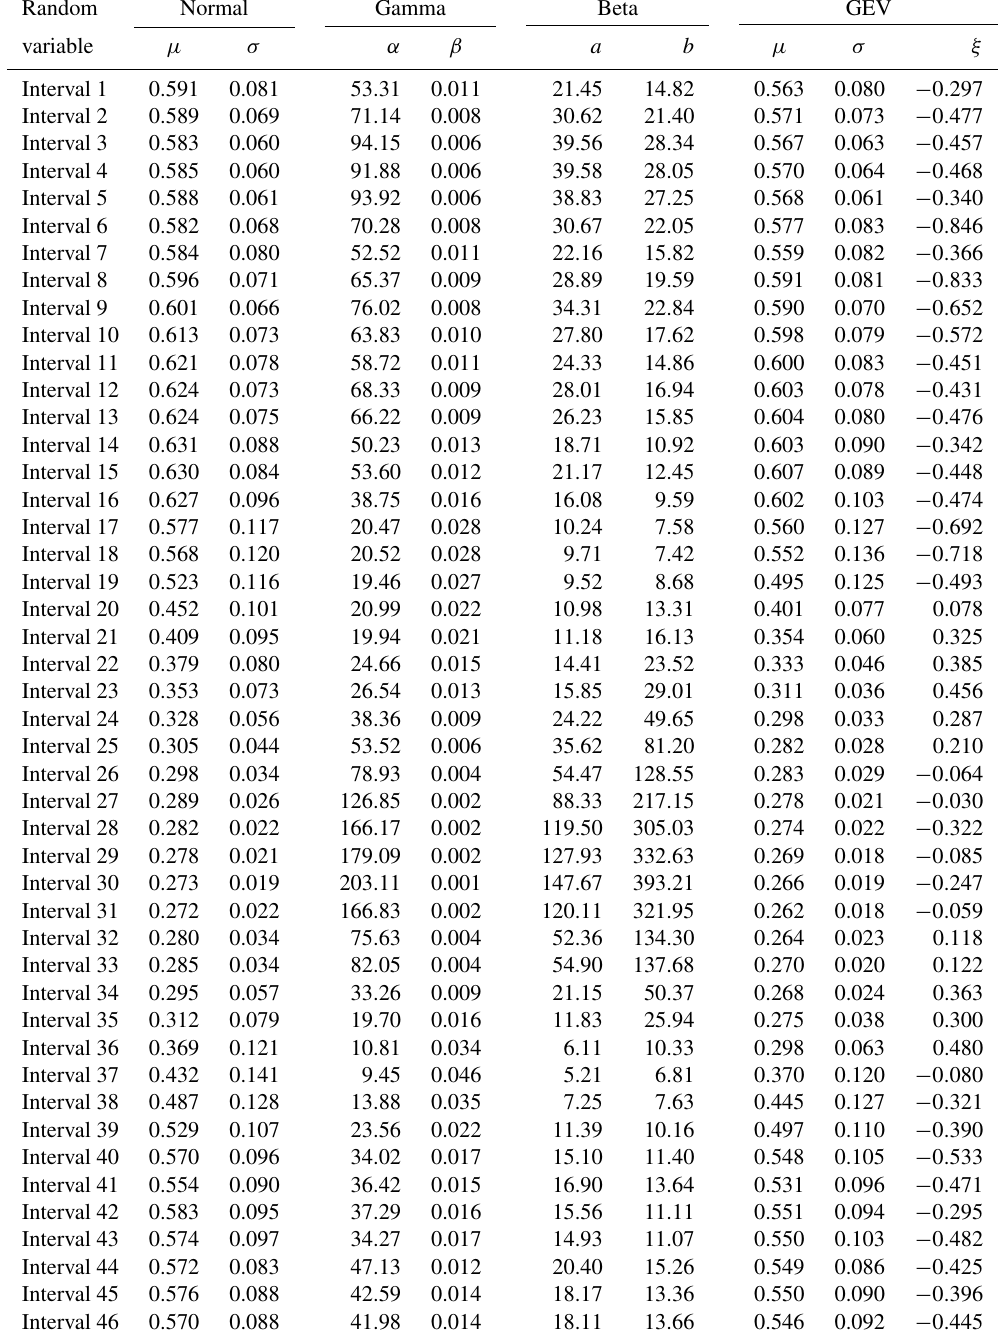
Table A1. Maximum likelihood parameters calculated for four PDFs. Random Normal Gamma Beta GEV variable µ σ α β a Interval 1